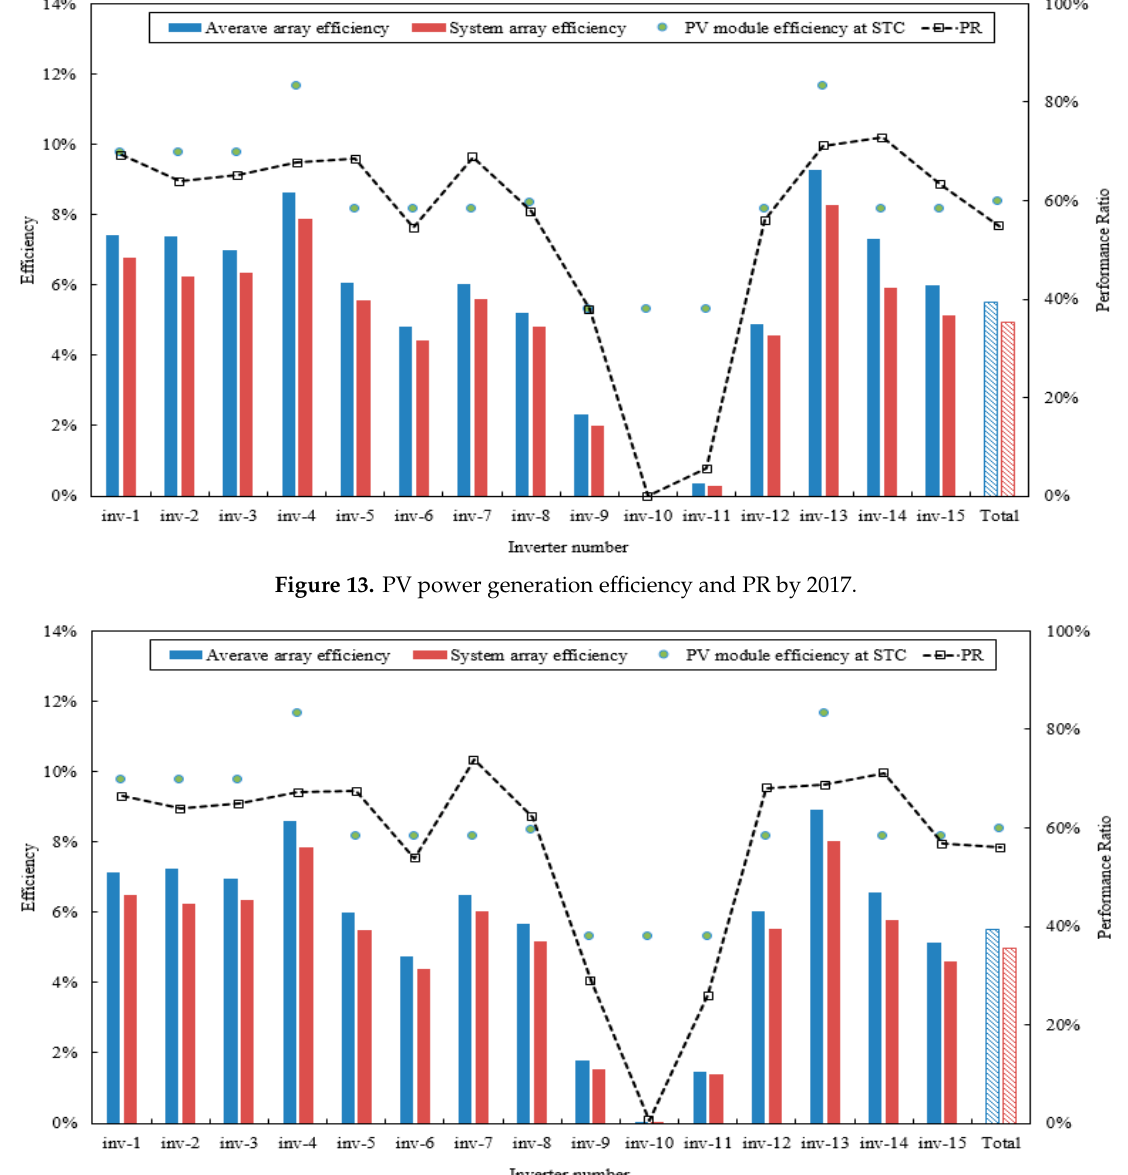
Figure 14. PV power generation efficiency and PR by 5 year average (2013 – 2017).